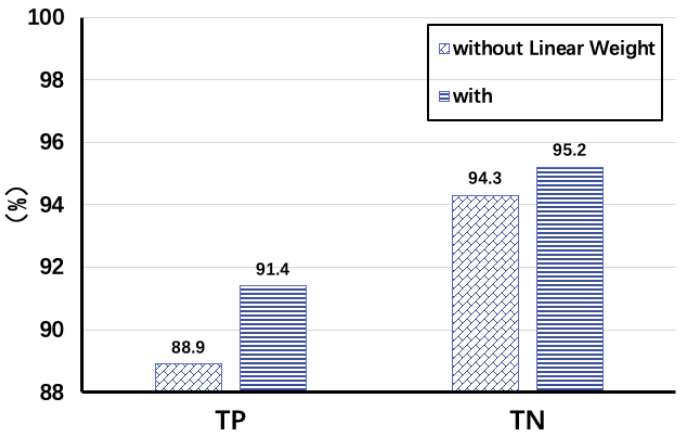
Figure 11. Change of TP/TN for different processing of data.